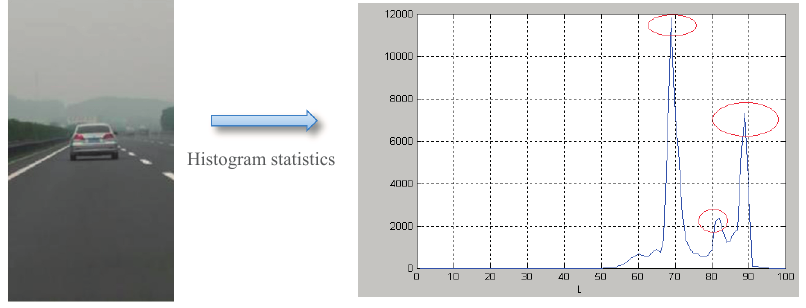
Figure 6. Histogram of L component.